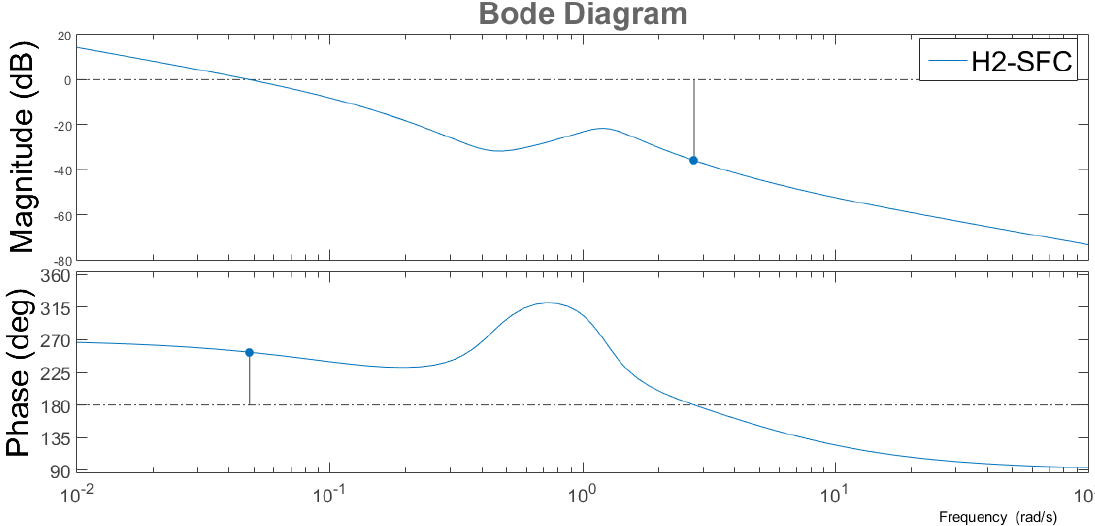
Figure 11. Phase margin of the H 2 -SFC controller against variations in the reference signal and external disturbances.